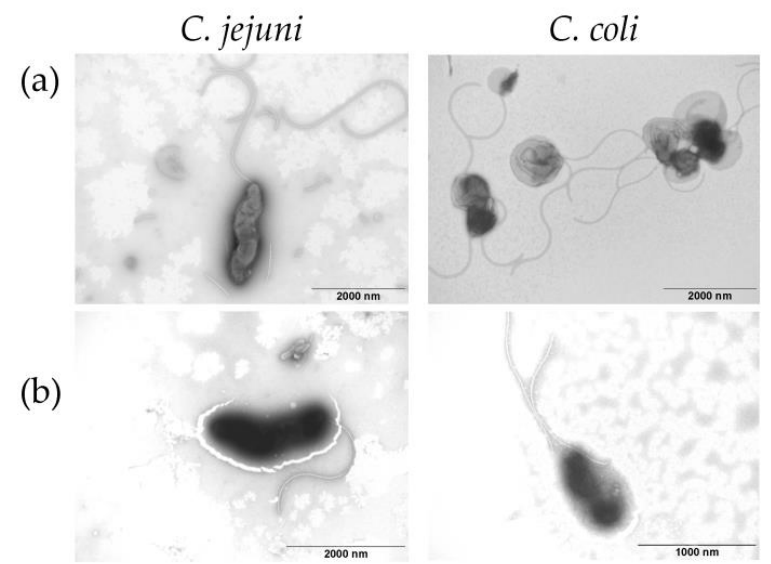
Figure 5. Effect of high-speed centrifugation on C. jejuni and C. coli cell morphology. Representative figures of electron microscopy ( a ) before and ( b ) after centrifugation. Magnification 14,000 × . Finally, the motility assay confirmed that centrifugation had no effect on C. jejuni and C. coli cell motility; they were both motile before and after centrifugation (Figure 6 and Figure S3). The motility assay together with cell number analysis, cell viability, and cell morphology support the conclusion that centrifugation has no effect on C. jejuni and C. coli . In summary, our results confirm that high-speed centrifugation does not harm bacterial